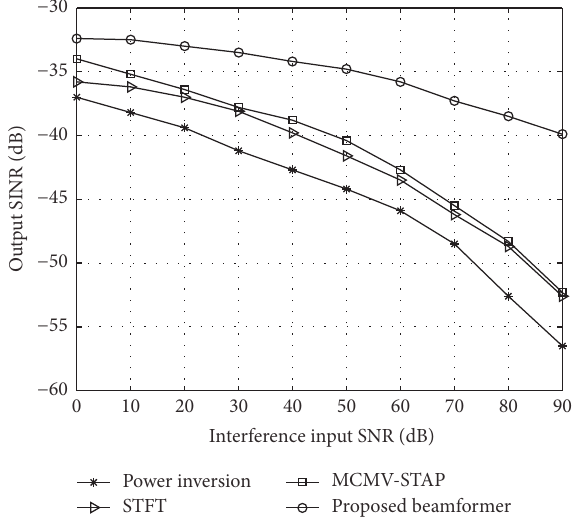
Figure 9: The output SINR of different method when suppress jamming: the angle of arrival of the satellite signal is 0 degrees and the angles of arrival of jamming signals are − 6 degrees and 12 degrees.